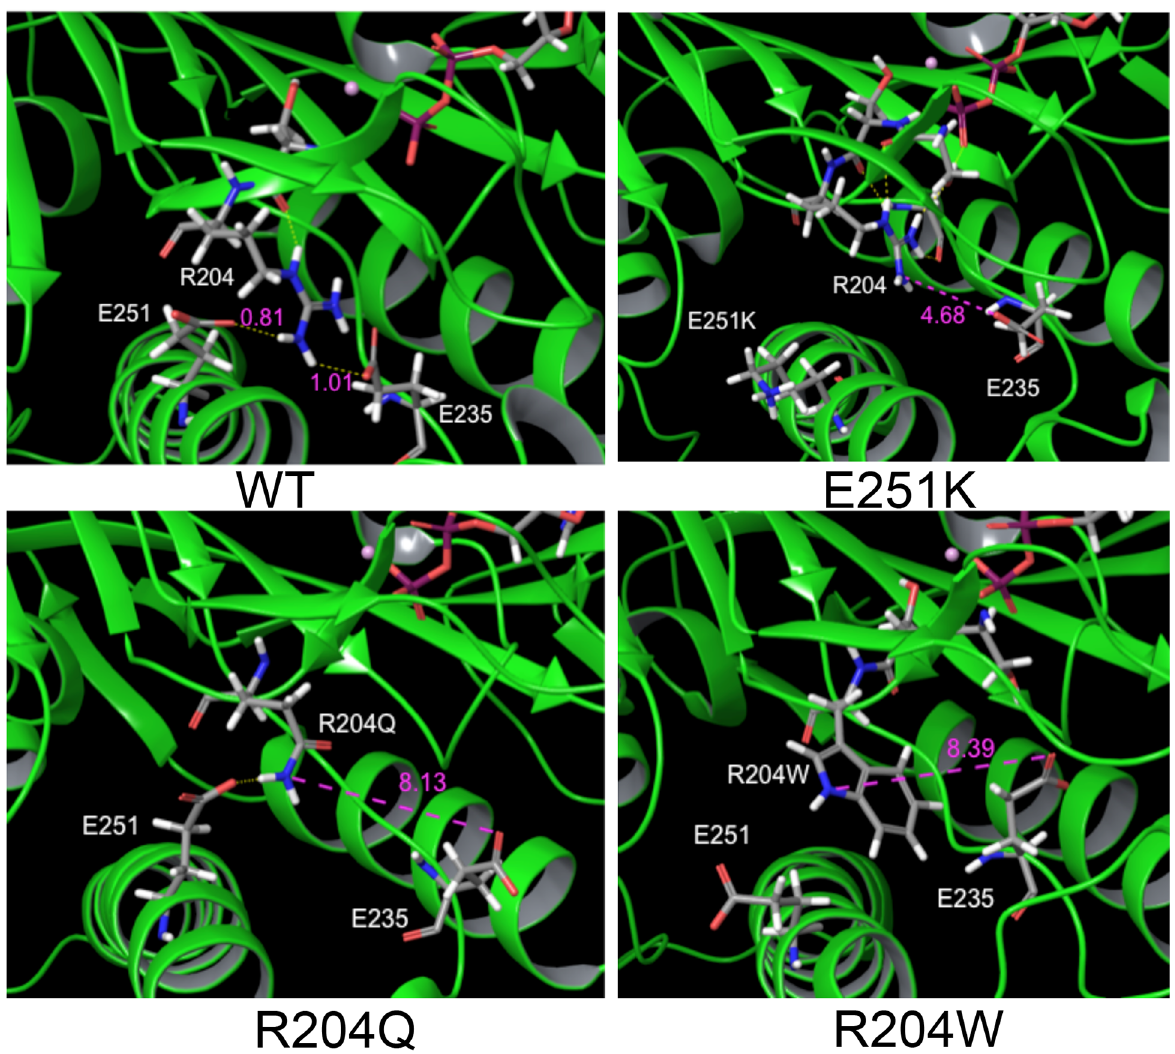
Fig 3. Molecular dynamics simulations of predicted altered kinesin structure. Images shownare the end point of a 10 ns simulationfor wild type or mutant kinesin using the 4HNA structure as a starting point. Amino acids of interest are labeledin white. Intramolecular distances betweenpotential bonding partners are shown in purple, with units of